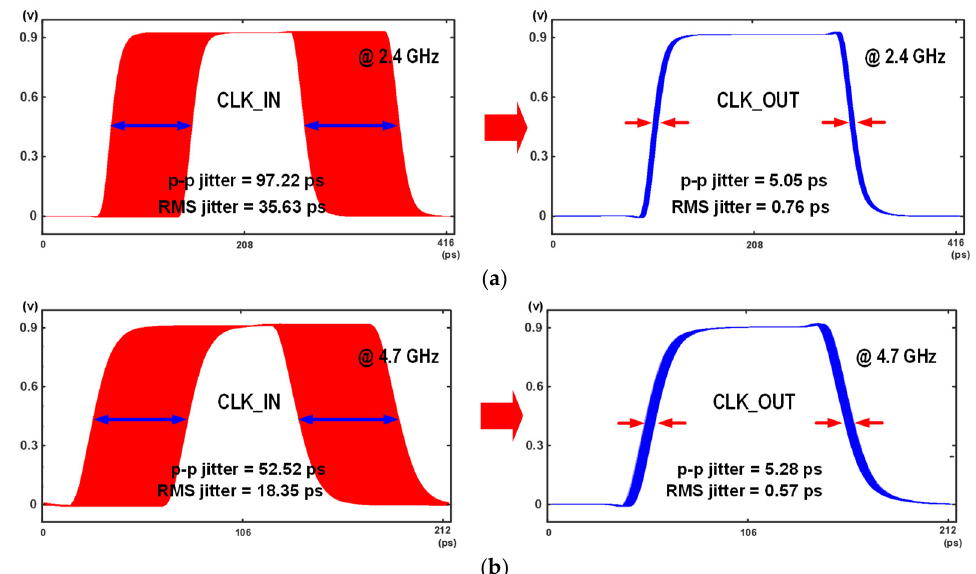
Figure 12. Post-layout simulation results of the proposed DJA showing input and output clock jitter eye diagram at ( a ) 2.4 GHz and ( b ) 4.7 GHz.